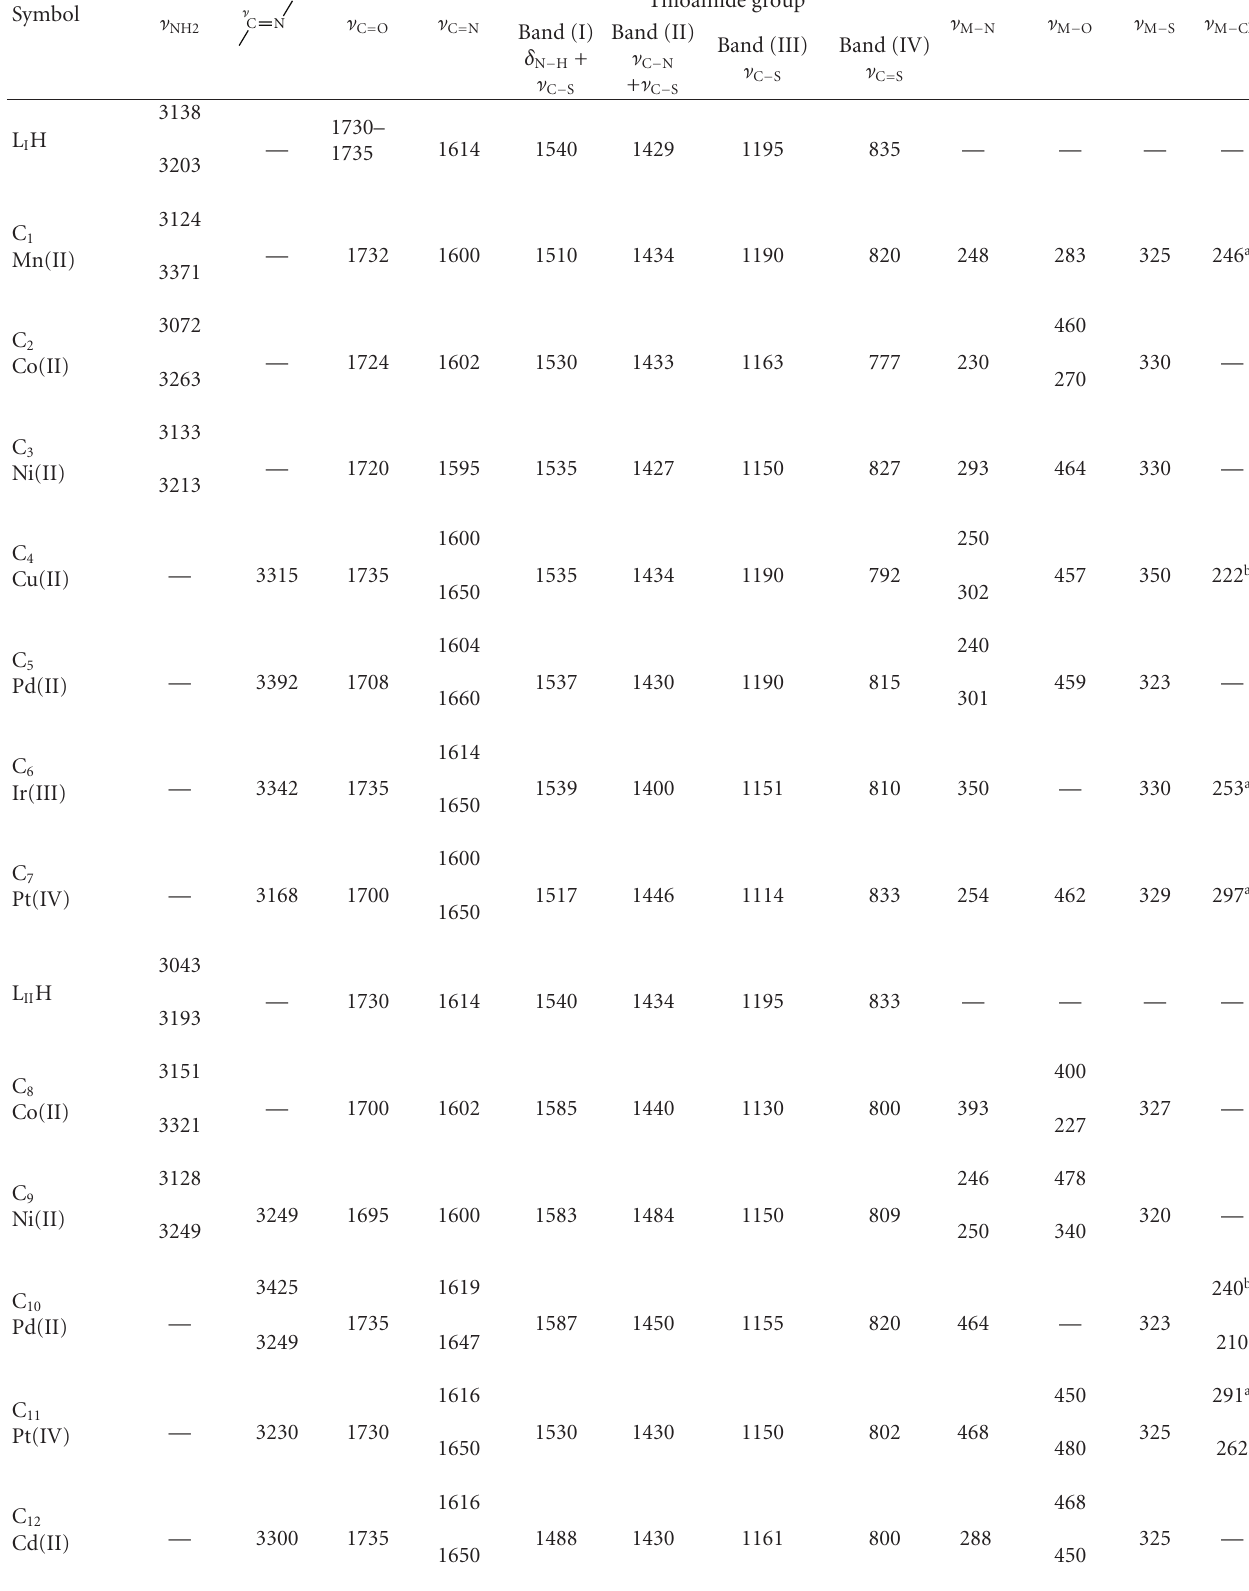
Table 2: Important I.R. vibrations (cm − 1 ) for the two Mannich and Schi ff base ligands and their metal complexes.